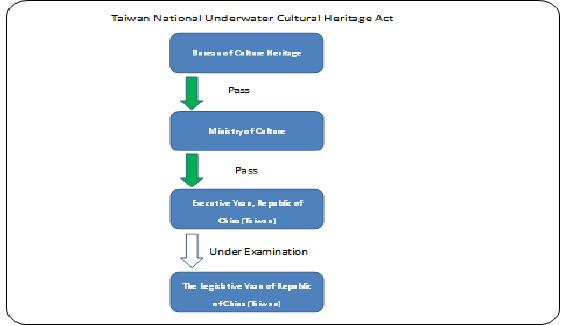
Figure 1. Legislative progress